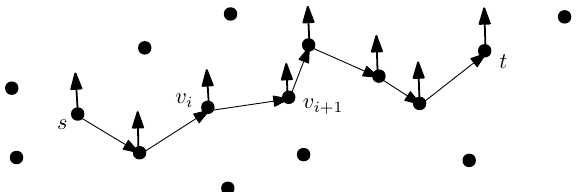
Figure 4. Flight path from source s to destination t . Edge ( v i , v i + 1 ) is an intermediate segment connecting landmarks v i and v i + 1 . The vertical (thicker) arrows represent the landmarks encountered by the